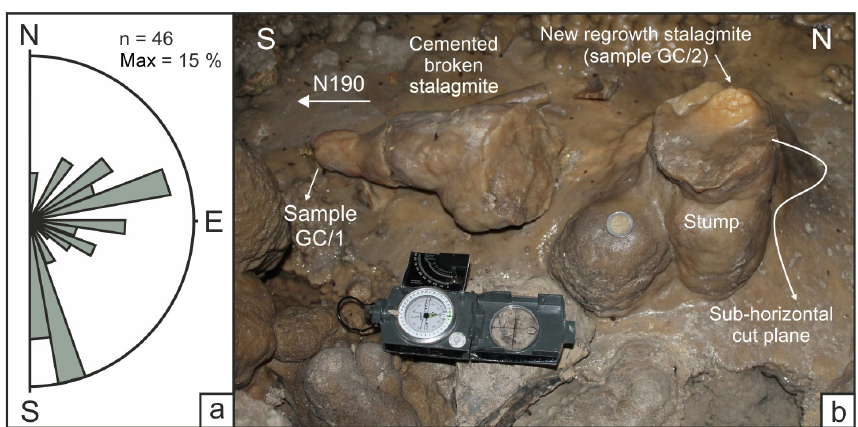
Figure 5. (a) Rose diagram of the measured orientations of fallen stalagmites cemented on the floor. Two main trends can be recognized: ENE-WSW and NNW–SSE, respectively orthogonal and parallel to the main active normal faults of the area. (b) Seismothem-like feature chosen for radiocarbon dating: stalagmite (originally ∼ 40cm high) broken along a sub-horizontal plane, fallen toward N190 and resting cemented on the floor (see Fig. 2d for the location). On the stump surface a ca. 2cm high new stalagmite is growing. “GC/1” and “GC/2” are the codes of the dated samples (see Fig. 6).